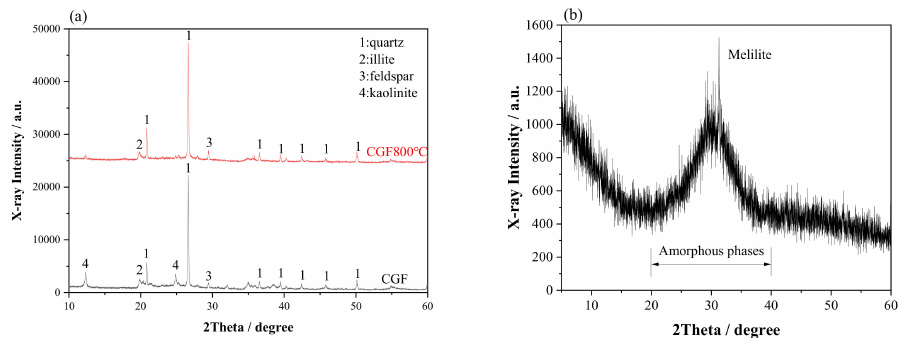
Figure 1. XRD pattern of raw materials: ( a ) CGF and ( b ) ground granulated blast furnace slag.